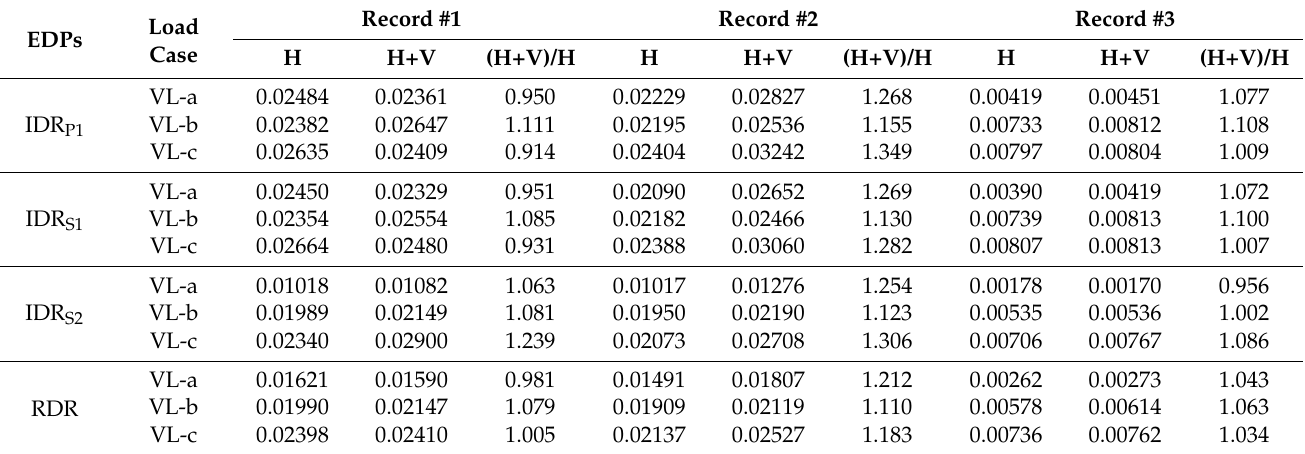
Table 6. EDPs obtained applied to the case–study structure of the selected records with and without the vertical component.